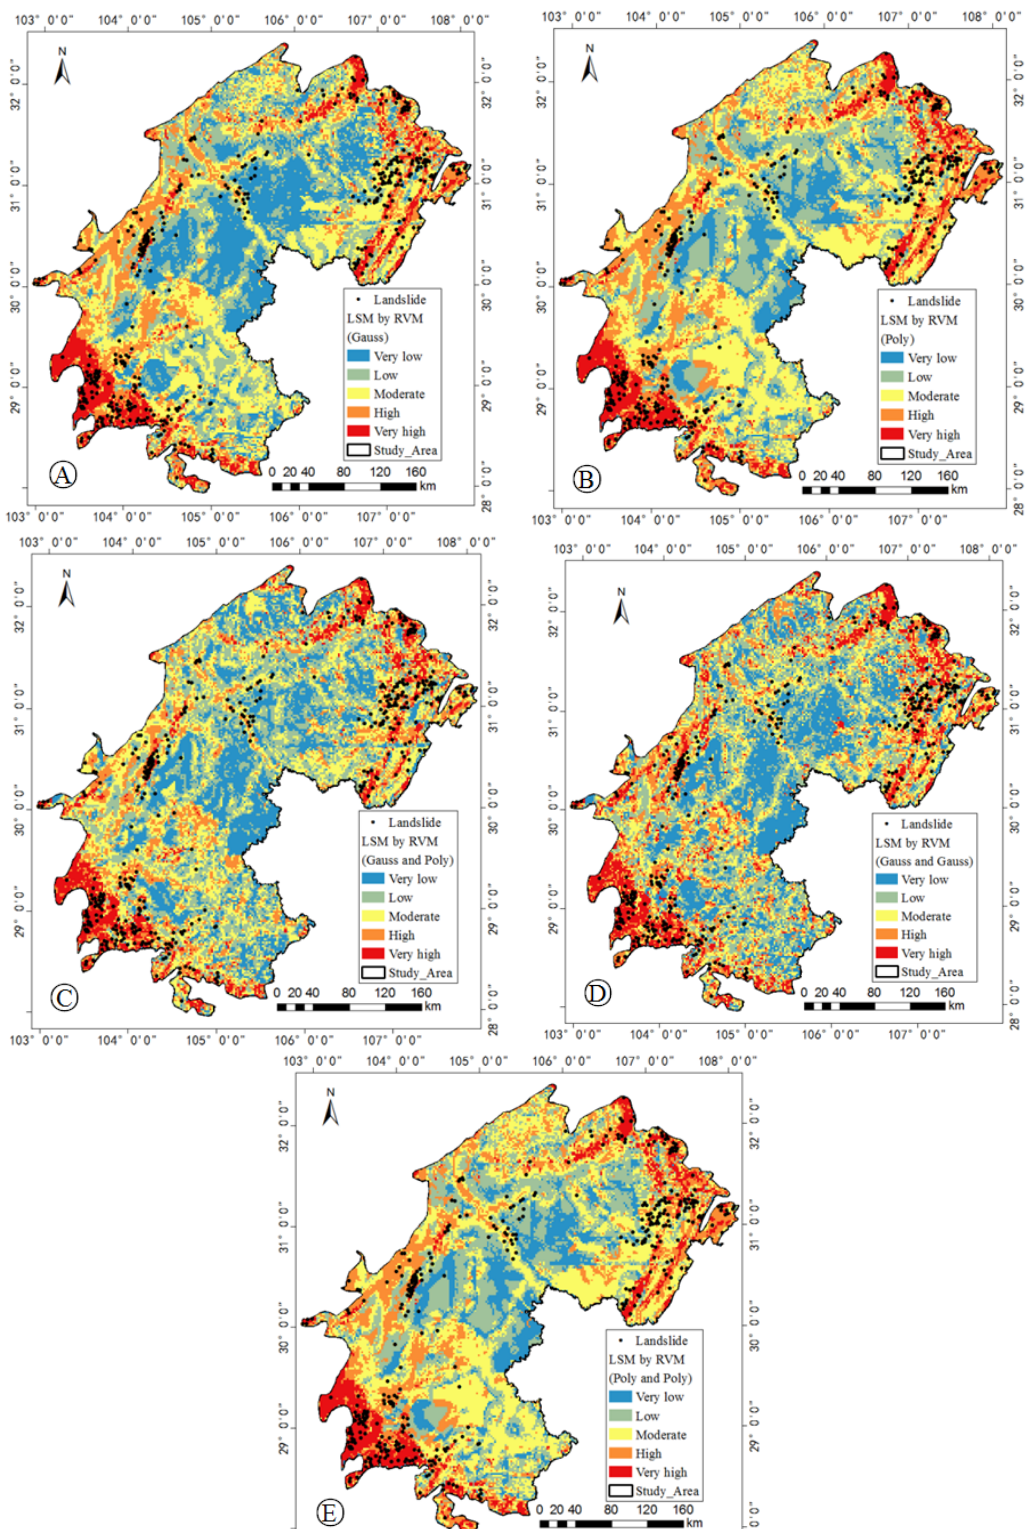
Figure 5. Landslide susceptibility maps of the hilly area in Sichuan. ( A ) Landslide susceptibility map (LSM) by Gaussian; ( B ) LSM by polynomial; ( C ) LSM by Gaussian and polynomial; ( D ) LSM by Gaussian and Gaussian; ( E ) LSM by polynomial and polynomial. RVM, relevance vector machine.